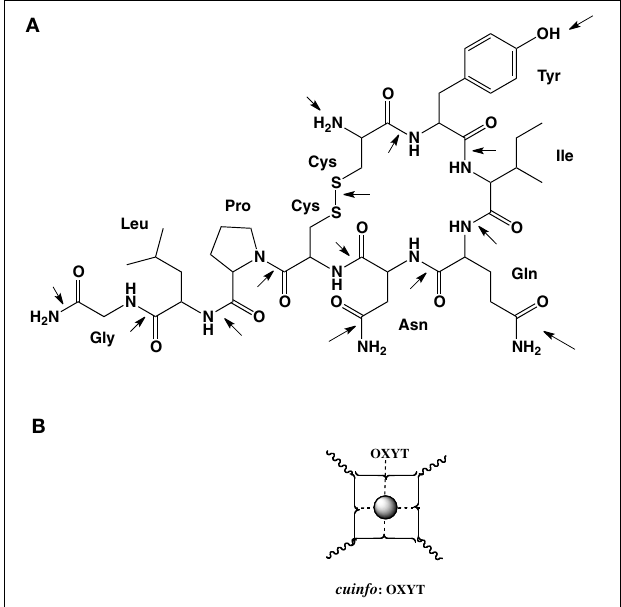
FIGURE 7 | (A) Molecular structure of oxytocin (OXYT), with 14 potential metal-complexing moieties marked with arrows. (B) Iconographic representation of a monodendate cuinfo :OXYT complex.